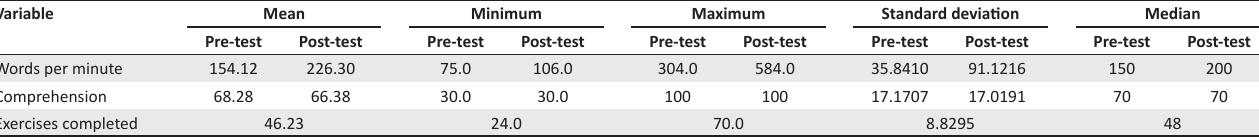
TABLE 1: Inferential statistics ( N = 93). Variable